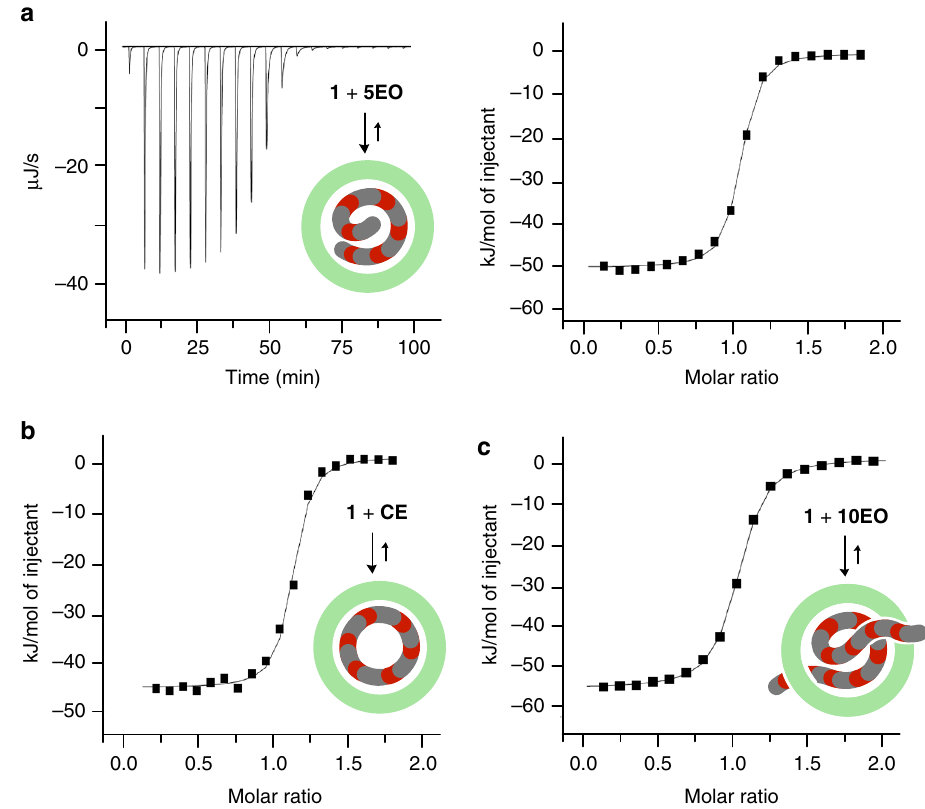
Fig. 4 ITC data for the formation of host – guest complexes 1 (cid:129) 5EO , 1 (cid:129) CE , and 1 (cid:129) 10EO . a ITC thermogram and binding isotherm (H 2 O, 298 K) of 5EO toward capsule 1 . ITC binding isotherms (H 2 O, 298 K) of b CE and c 10EO toward 1